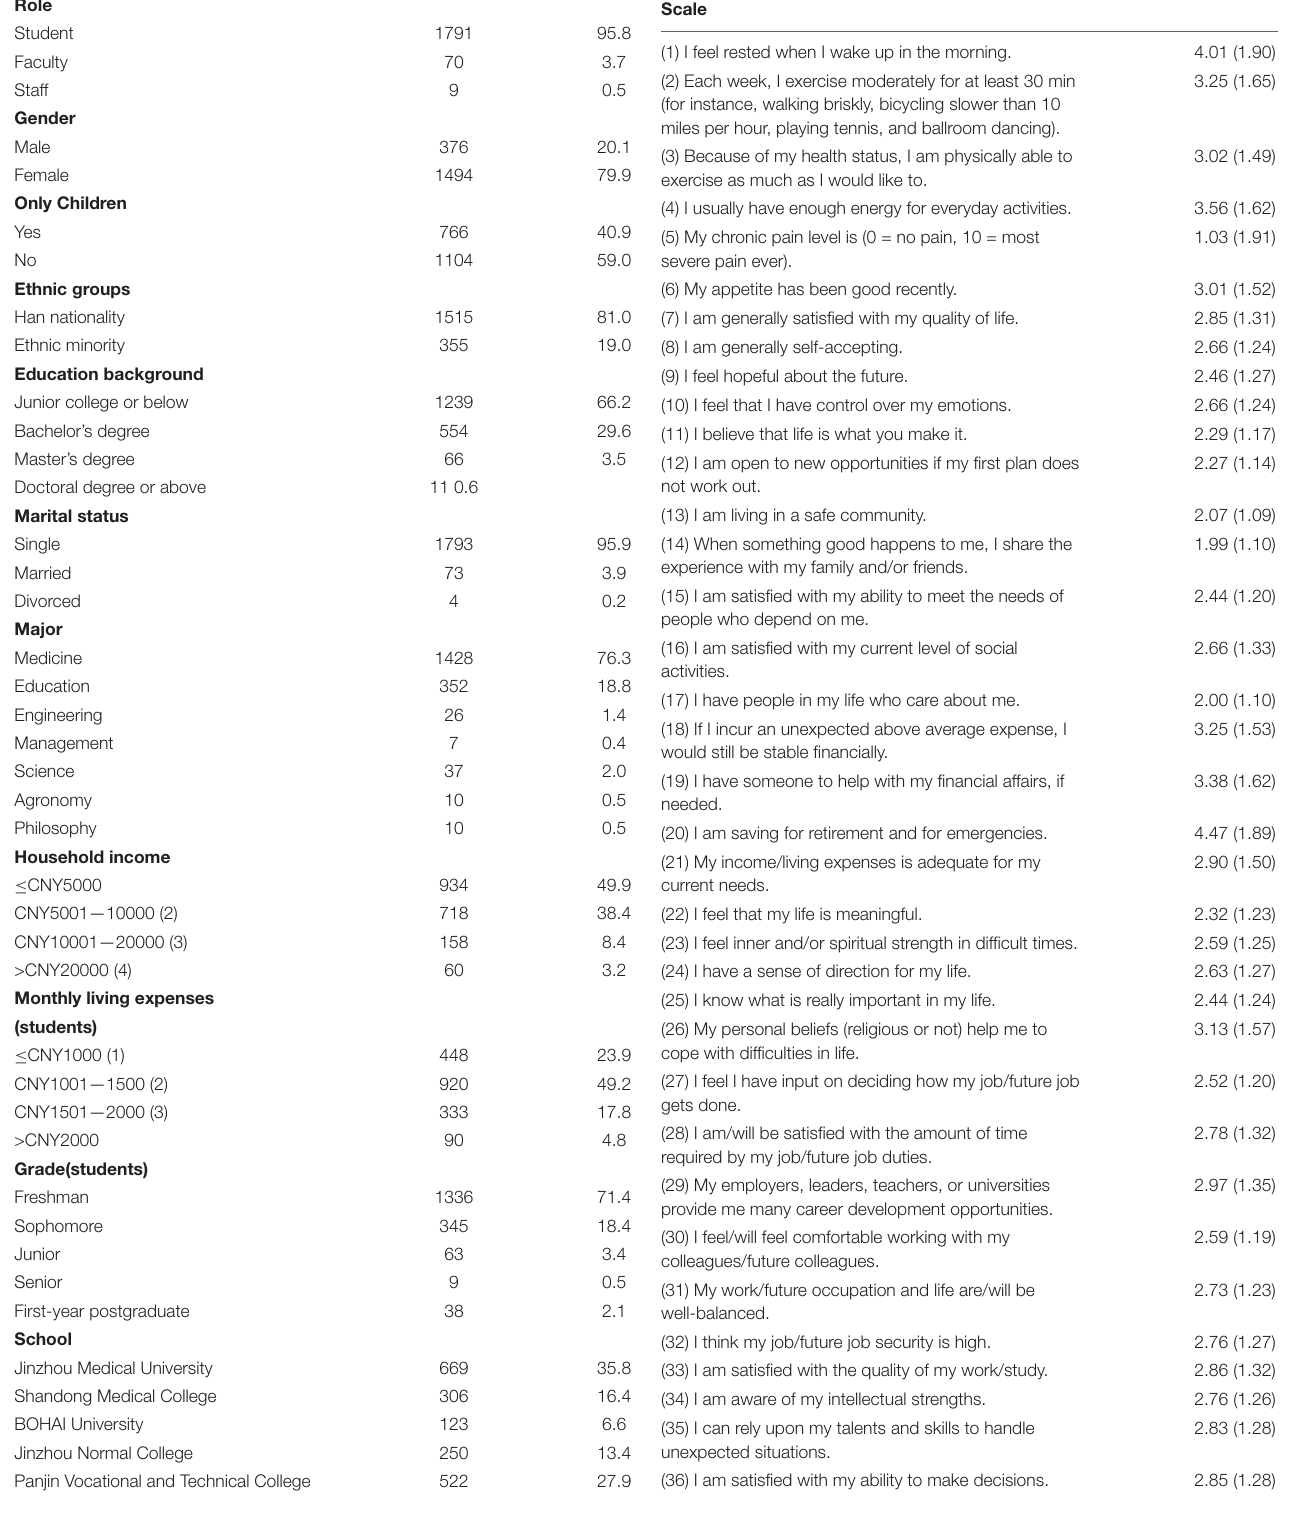
of the Pitt Wellness Scale ( N = 1870). Items on Chinese Revision